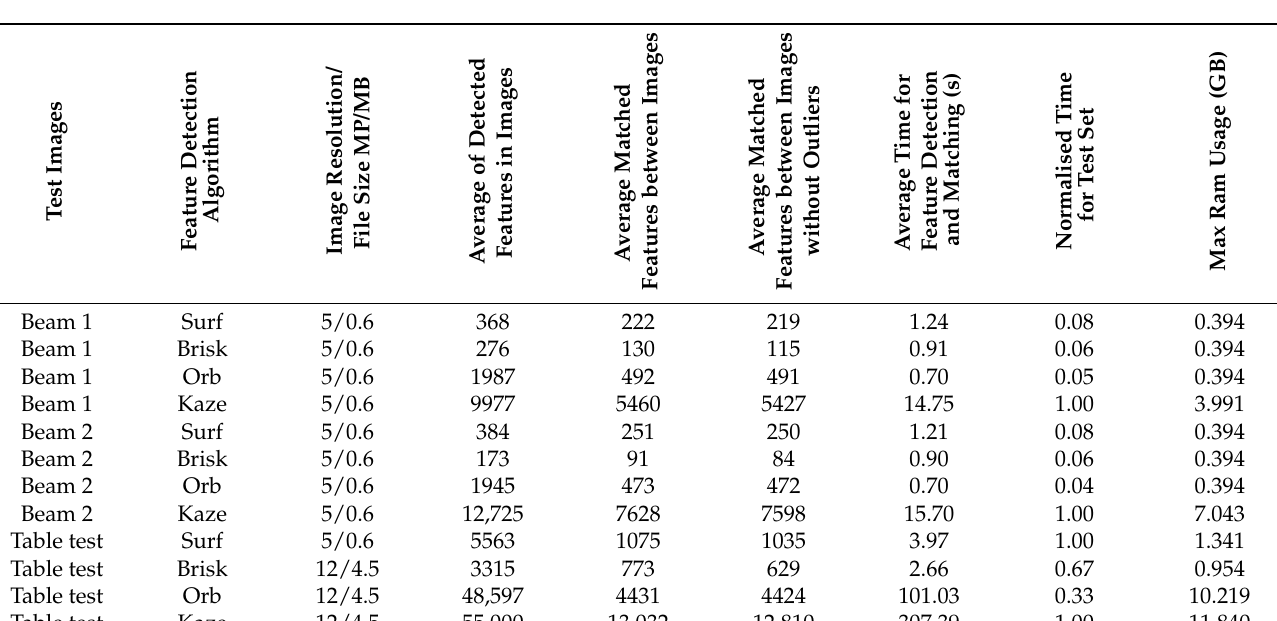
Figure 14. Images used in the first series of tests ( left —BEAM 1, middle —BEAM 2, right —table test image) (Source: Own compilation). Table 3. Results of the first series of test for image feature and matching algorithms.